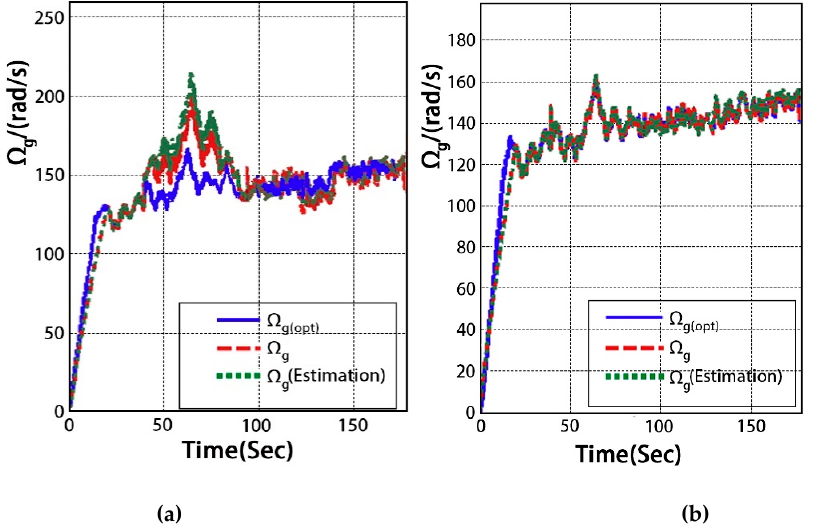
Ω . (a) Without using the FRSFTC strategy; (b) Using the FRSFTC r